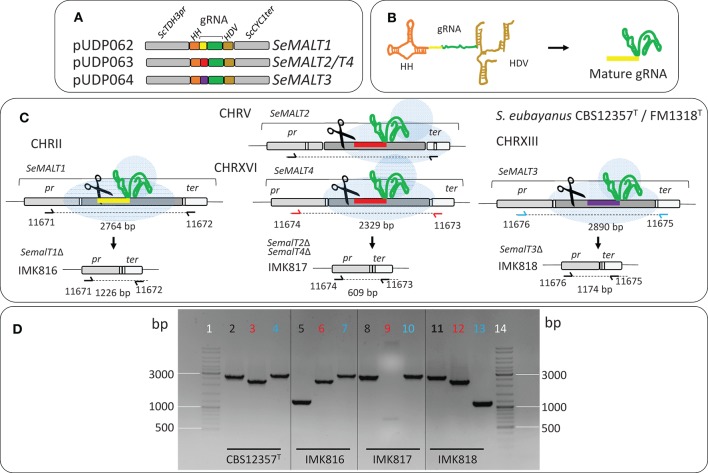
Deletion of SeMALT genes using CRISPR-Cas9-assisted genome editing in S. eubayanus CBS 12357T. (A) Representation of the gRNA expression cassette in pUDP062, pUDP063, and pUDP064. gRNAs targeting either SeMALT1, SeMALT2/T4 or SeMALT3 were flanked by a 5′ hammerhead ribozyme (HH, orange) and a 3′ hepatitis-δ virus ribozyme (HD, bronze). These constructs were expressed from the RNA polymerase II ScTDH3 promoter and the ScCYC1 terminator. (B) Upon ribozyme self-cleavage, a mature gRNA comprising the SeMALT guiding spacer (yellow) and the constant structural gRNA fragment (green) is released. (C) Schematic representation of SeMALT gene editing upon transformation of pUDP062 or pUDP063 or pUDP064 into S. eubayanus CBS 12357T. Primers used for verification of transformants from transformation are indicated together with the size of the expected PCR products. (D) Validation of transformants derived from transformations of S. eubayanus CBS 12357T with either pUDP062, pUDP063 or pUDP064 in presence of the corresponding 120 bp repair DNA fragments. Lanes 1 and 14 GeneRuler DNA Ladder Mix (Thermo Fischer Scientific). Lanes 2, 5, 8, and 11 fragments amplified with primers 11671 and 11672 black label). Lanes 3, 6, 9, 12 fragments amplified with primers 11674 and 11673 (red label). Lanes 4, 7, 10, and 13 fragments amplified with primers 11676 and 11675 (blue label) from genomic DNA from CBS 12357T (Lanes 2, 3, and 4), from IMK816 (SemalT1Δ) (Lanes 5, 6, and 7), from IMK817 (SemalT2Δ/ SemalT4Δ) (Lanes 8, 9, and 10), and from IMK818 (SemalT3Δ) (Lanes 11, 12, and 13).